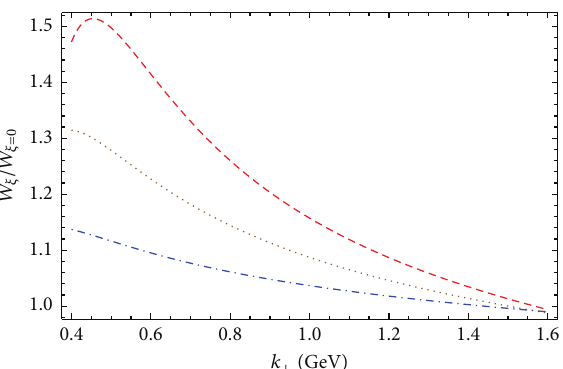
Figure 2: Variation of the noneikonal radiation spectrum scaled by the eikonal spectrum ( 𝜁 = 0.0 ) off heavy quark ( Δ 𝑀 = 0.1 ) with gluon transverse momentum. Red (dashed): 𝜁 = 0.15 ; brown (dotted): 𝜁 = 0.30 ; blue (dot-dashed): 𝜁 = 0.45 .